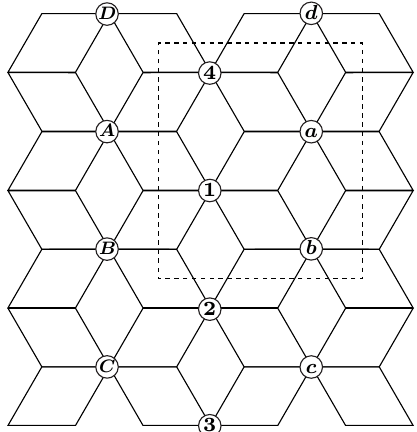
Figure 28 . Example of the bipartite graph from (cid:6) 1 ; 4 . The dotted square is the fundamental